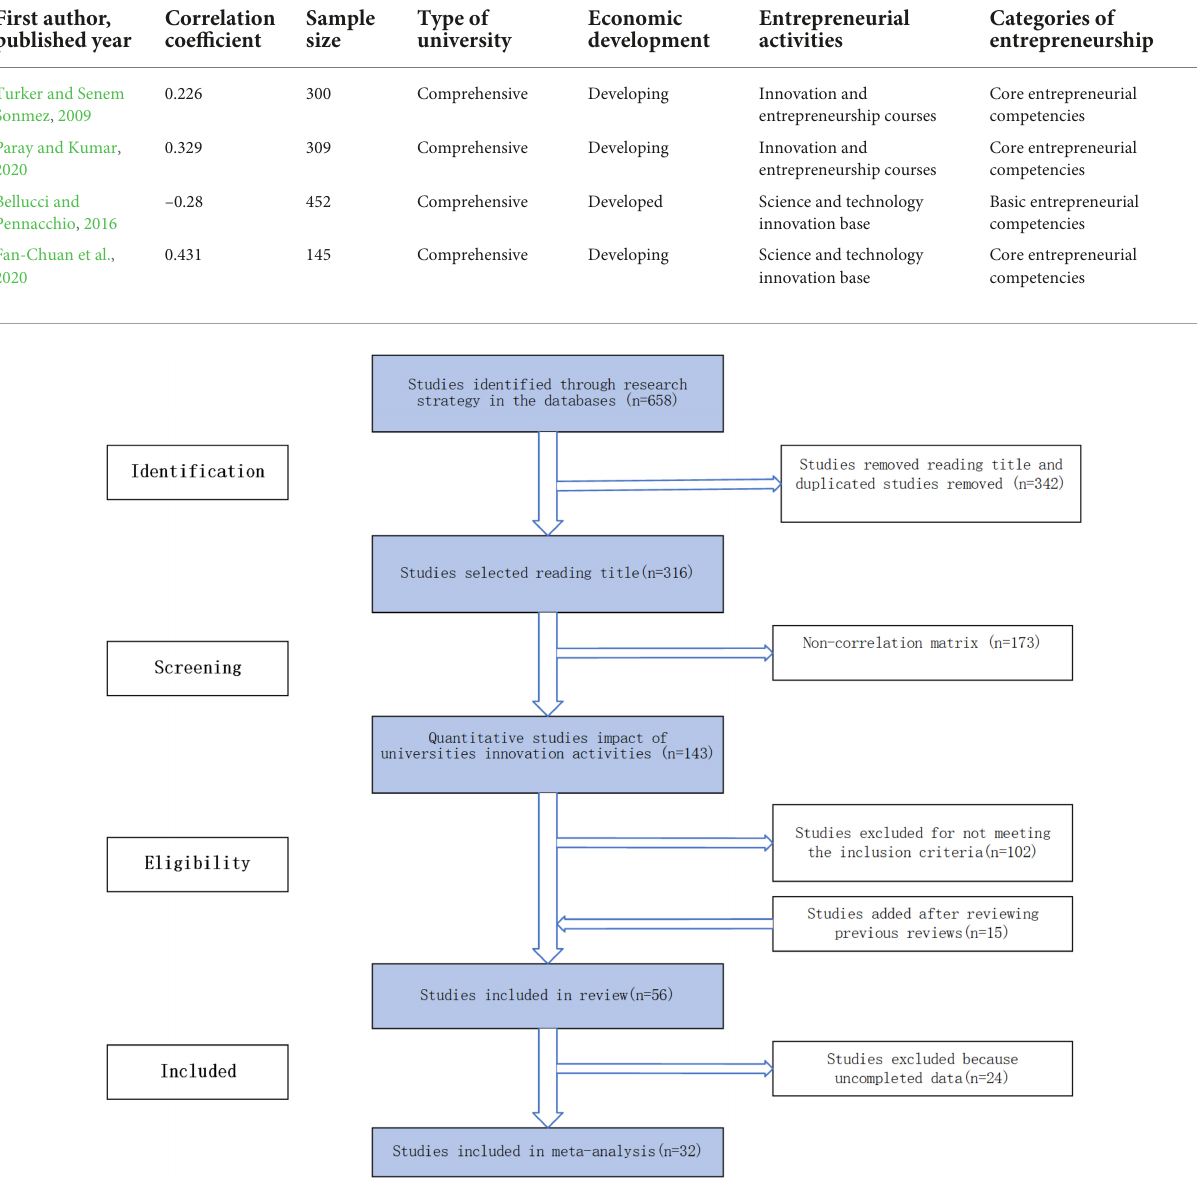
size and correlation coefficient r. After several searches and screenings, 32 empirical articles containing correlation coefficient tables were identified, with a total sample size of 12,873, an average sample size of 402, a maximum sample size of 1428, and a minimum sample size of 109. The final literature data were imported into the CMA3.0 software, and after several analysis operations, the final results were obtained. Thirty-two empirical articles can be found in Table 1 and detailed results are shown in Figure 2 .